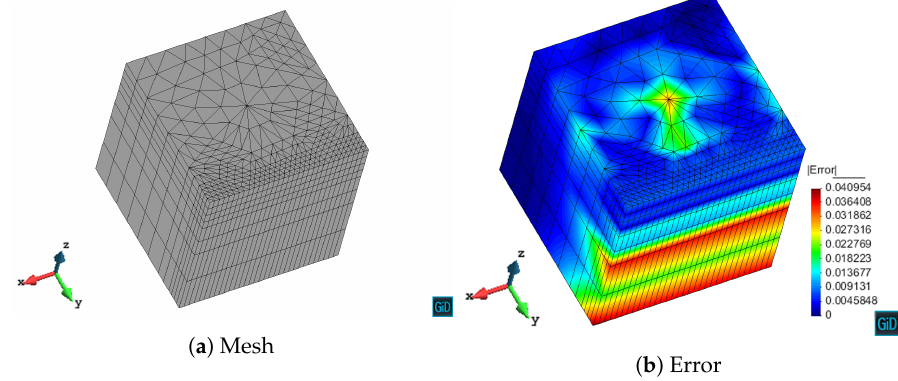
Figure 3. Presence of anomaly ( eye ) in the refined mesh.